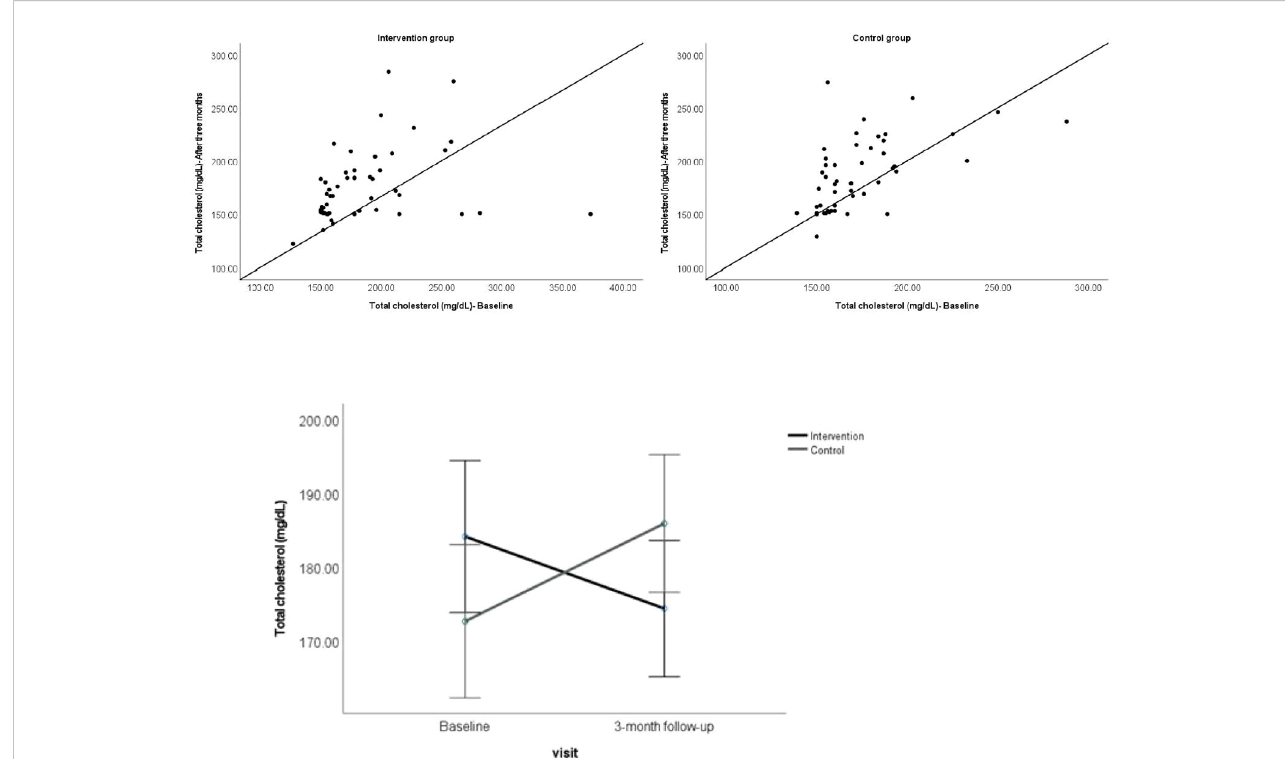
FIGURE 2 Above. Scatterplot showing the total cholesterol for individual participants at baseline against 3-month follow-up visit. Below. Showing the mean total cholesterol for the participant groups at baseline and 3-month follow-up visit. Error bars represent 95%